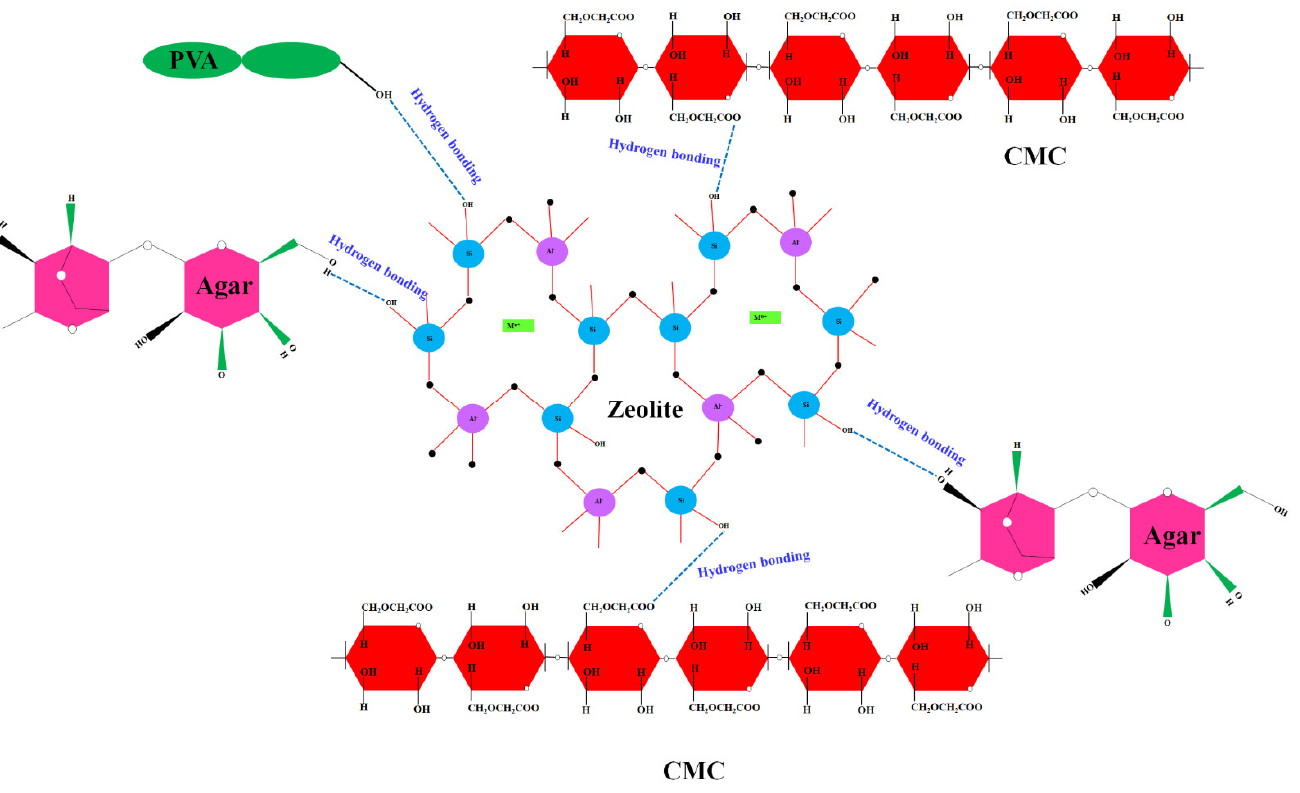
Scheme 2. Schematic representation of hydrogen-bond interaction among the hydroxyl groups of zeolite, the carboxyl group of cellulose and the hydroxyl group of agars.